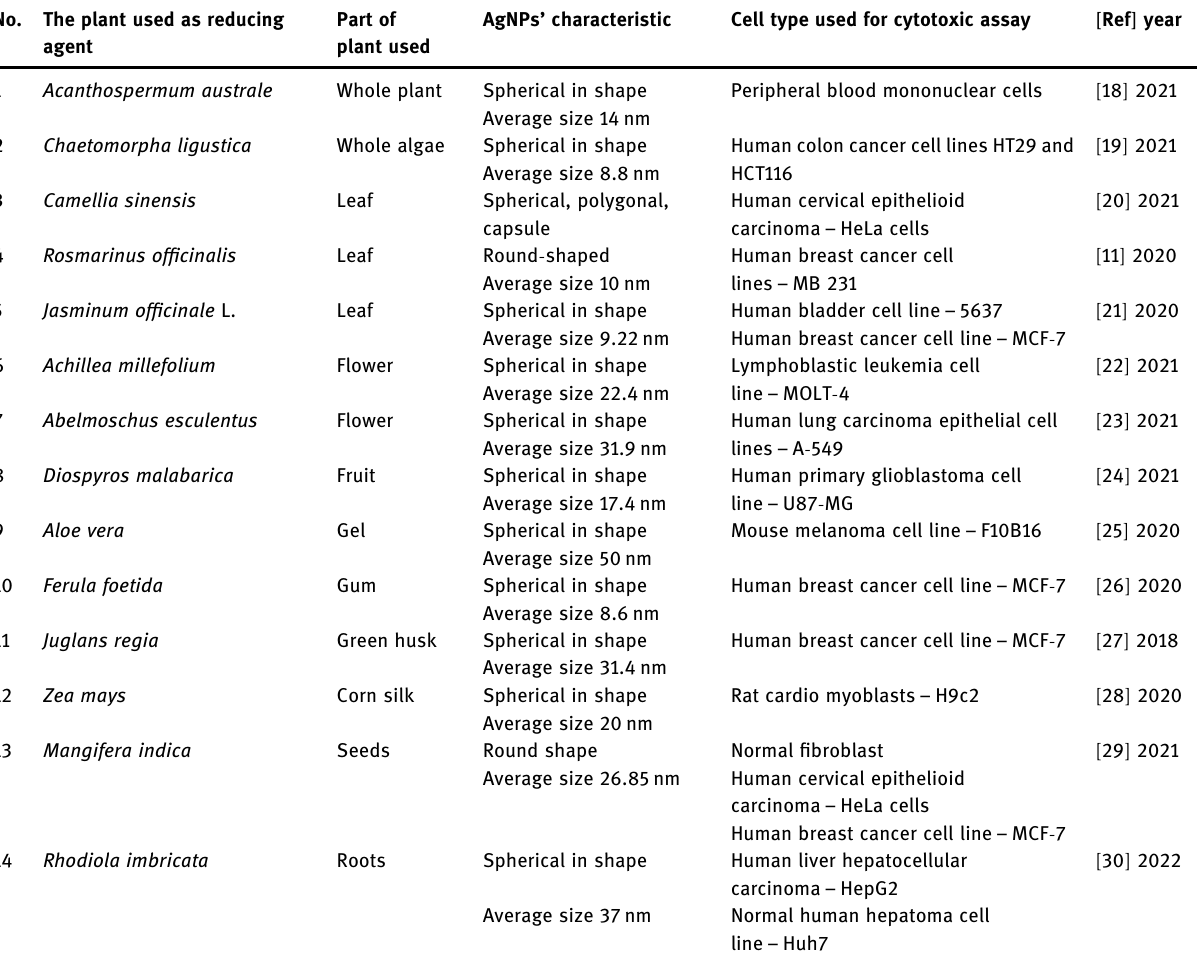
Table 1: Most recent reported AgNPs synthesized by various plant parts No. The plant used as reducing